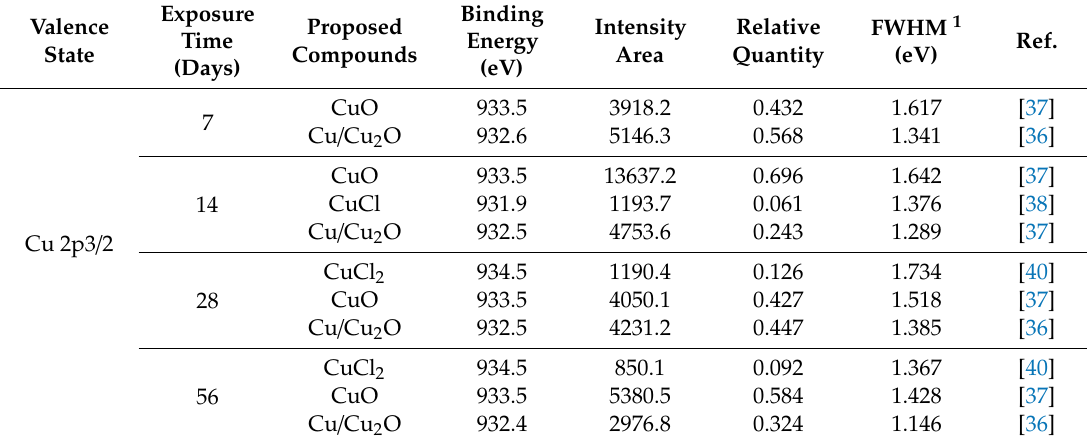
Table 2. Fitting parameters for Cu 2p3 / 2 XPS spectra and relative quantity of compounds in the corrosion layers of 90 / 10 Cu-Ni alloy exposed to seawater for di ff erent